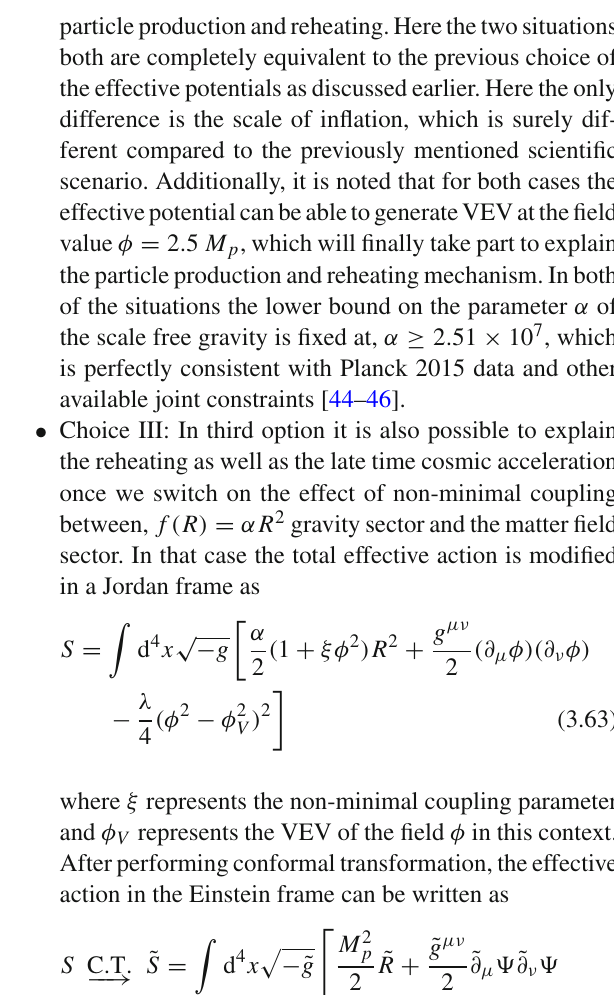
( a ) Choice I ( v1 ) : Modified potential from superstring the- ory with λ < 0. Fig. 4 Behavior of the modified effective potential for case II with a Choice II(v1): V 0 (cid:11)= 0, λ < 0, m 2 c > 0 and φ (cid:14)